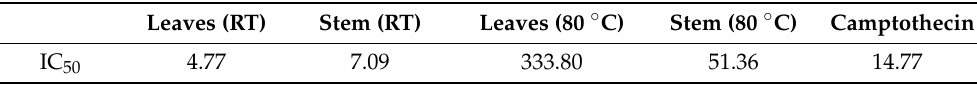
Table 8. IC 50 values of D. villosa leaves and stem bark nanoparticles at both RT and 80 ◦ C against HEK293